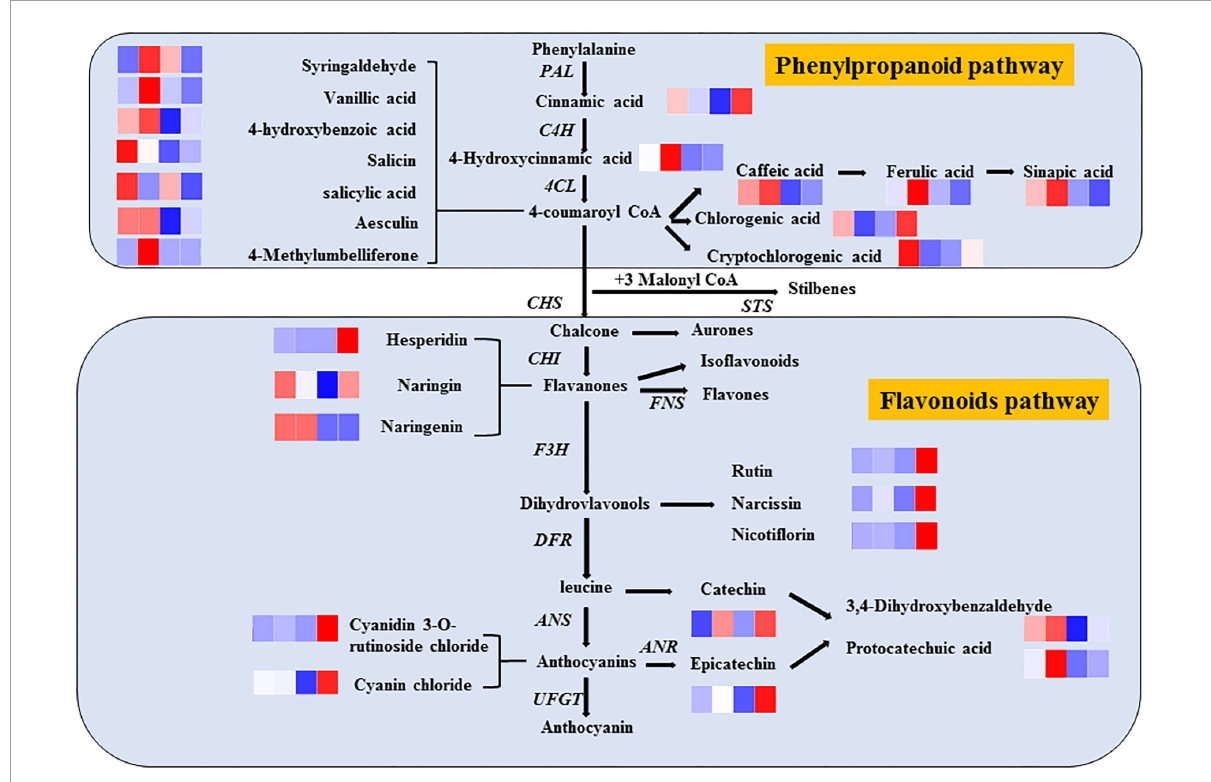
FIGURE7 Metabolic pathways of ozone-induced phenolic accumulation in fresh-cut red pitaya fruit. The cluster heatmap showed all detected phenolic acids and flavonoid metabolites. The upregulated and downregulated metabolites were expressed by different shades of red and blue, respectively. As the abundance value increases, the color of the bar graph changes from blue to red. If the abundance value is zero, the color of the column is